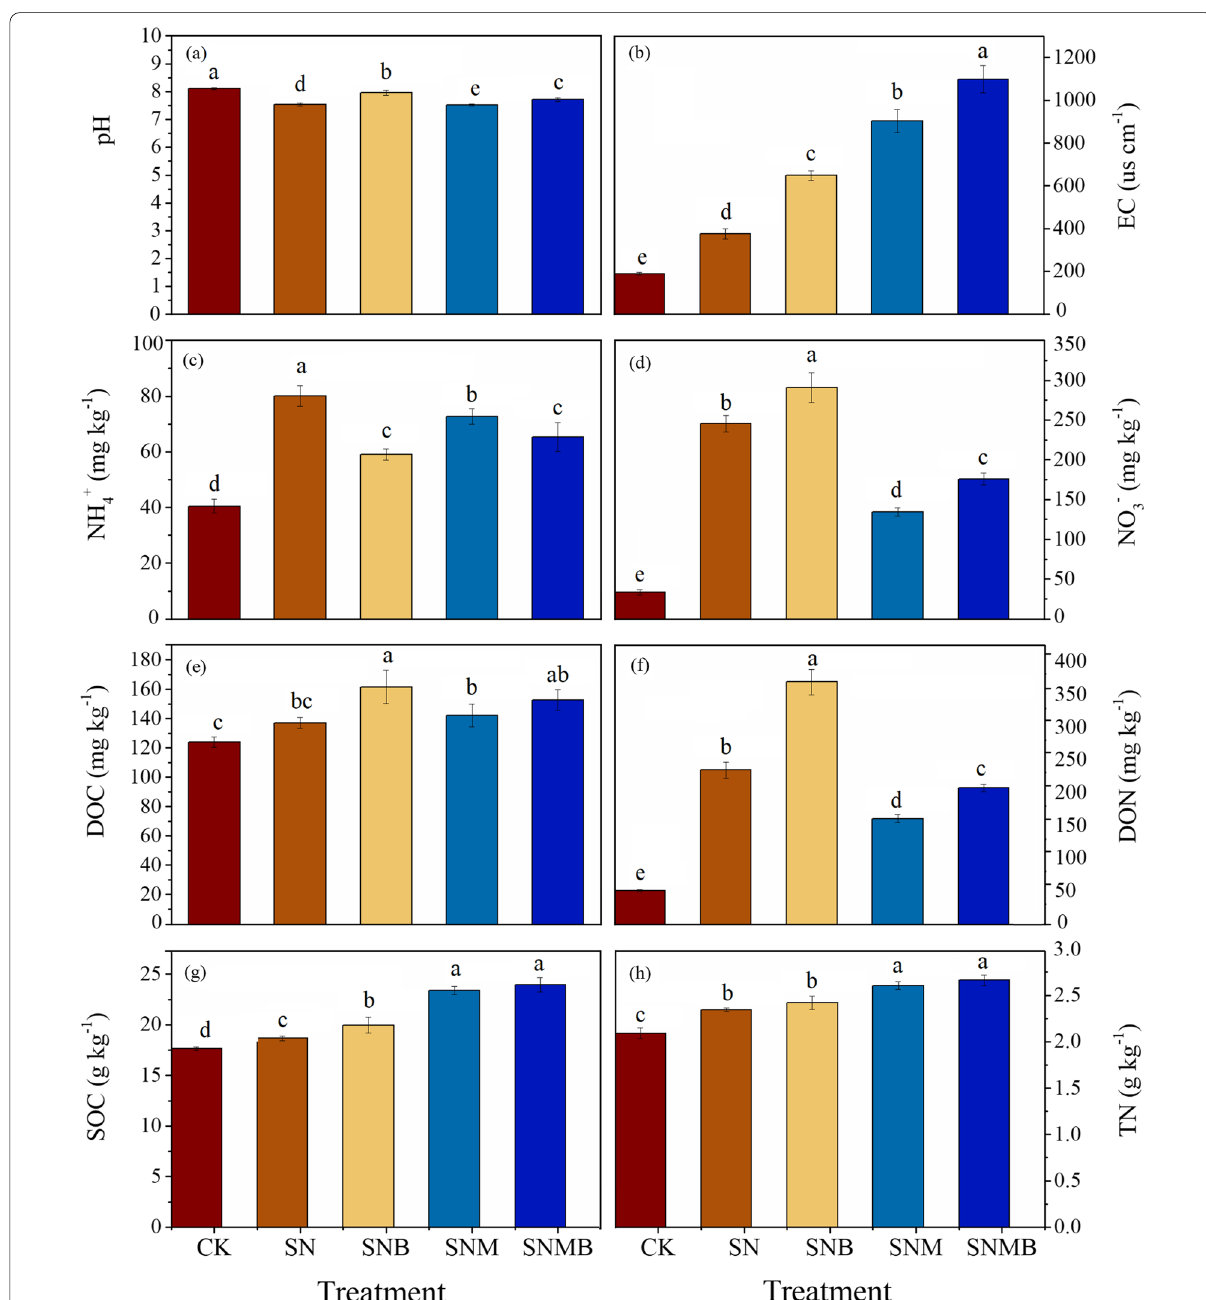
Fig. 2 The average soil pH ( a ), EC ( b ), NH 4 + ( c ), NO 3 − ( d ), DOC ( e ), DON ( f ), SOC ( g ), and TN ( h ) under different treatments over a 5-year period of intensive vegetable production. Different letters above the bars indicate significant differences among the different treatments (p < 0.05). Bars indicate the standard